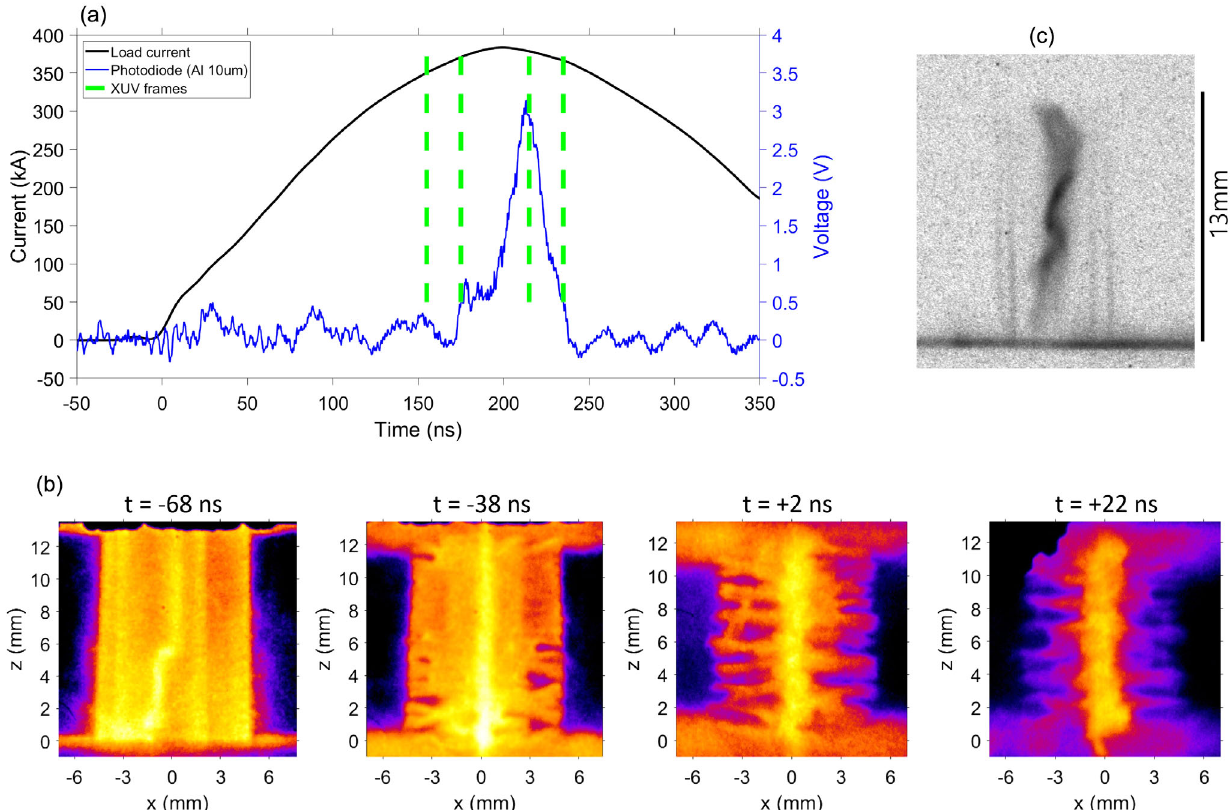
FIG. 7. Example of a wire array Z -pinch experiment on CESZAR, using 4 × 7 . 5 μ m diameter wires arranged in a 10 mm circle. (a) Current pulse, x-ray photodiode signal, and XUV time-gated camera frame times. (b) Sequence of time-gated XUV pinhole images. The color scheme and contrast of the images has been enhanced for clarity. The time stamp relative to the x-ray peak emission is reported above each image. (c) Time-integrated pinhole image filtered with a 3.5 μ m aluminized Mylar foil; this image comes from a different shot than (a) and (b), in order to show a precursor kink structure characteristic of a current-carrying plasma column. In all images, the anode is at the